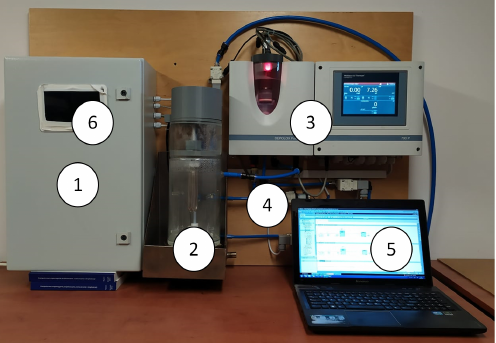
Figure 2. Test stand: 1: control cabinet, 2: reactor, 3: set of probes with the controller, 4: hydraulics system, 5: computer, 6: